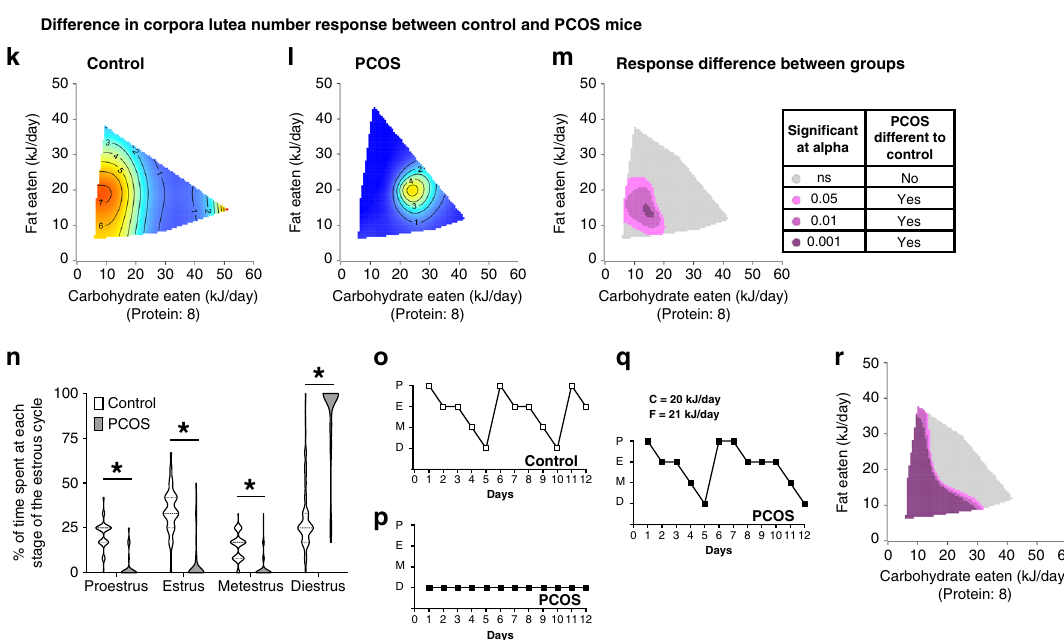
Selective macronutrient intakes rescue ovulatory dysfunction . Irregular menstrual cycles and ovulatory dysfunction are key diagnostic features of PCOS 10 . In this study, irrespective of diet and consistent with our previous studies 25,26 , PCOS mice exhibited a signi fi cant disturbance of ovulatory function with a decrease in corpora lutea (CL) number (0.5 ± 0.2) compared to control mice (4.5 ± 0.6) ( P < 0.001, Fig. 1a – c). However, CL were